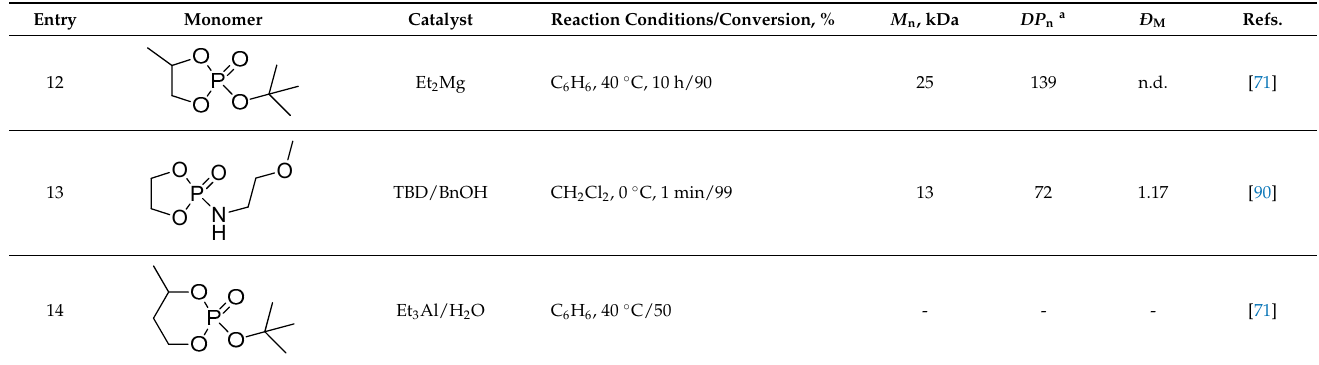
MeOEP represents the simplest five-membered cyclic phosphate. Minimal sterical hindrance in phosphorus atoms complicate the ROP of MeOEP by the formation of branched polymers. Coordination catalyst Mg1 demonstrated high activity in polymeri- zation of MeOEP at –20 °C with a formation of a mainly linear polymer [62,91]; however, when using an organocatalyst TBD, highly branched polymers formed [62,79]. Nifant’ev and coll. found that TBD-catalyzed polymerization of MeOEP in the presence of trime- thyl phosphate leads to linear poly(MeOEP) with given DP n and narrow molecular weight distribution (MWD) even at a >99% monomer conversion degree [79]. Note that the DBU/TU catalyst was moderately active in the polymerization of MeOEP [62,78].